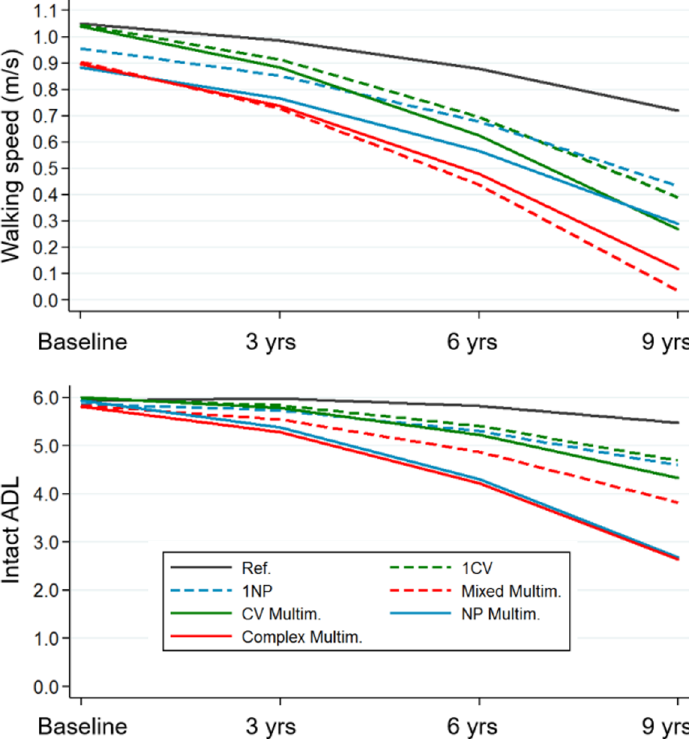
Fig 3. Trajectories of walking speed and ADL impairment over 9 years by clinical patterns. Trajectories derived from multilevel mixed-effect linear regression models adjusted for baseline age, sex, education, malnutrition, institutionalization, and number of medications. Reference group: participants free from cardiovascular and/or neuropsychiatric diseases. ADL, activities of daily living; CV, cardiovascular; Multim., multimorbidity; NP, neuropsychiatric; Ref., reference